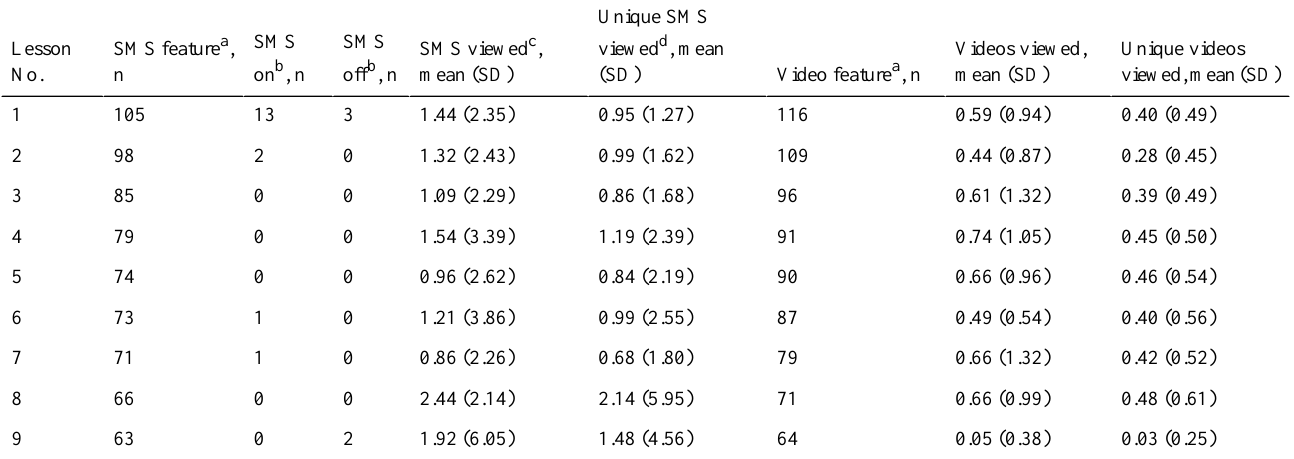
Table 2. Mean use of features, per lesson for the features SMS and video.